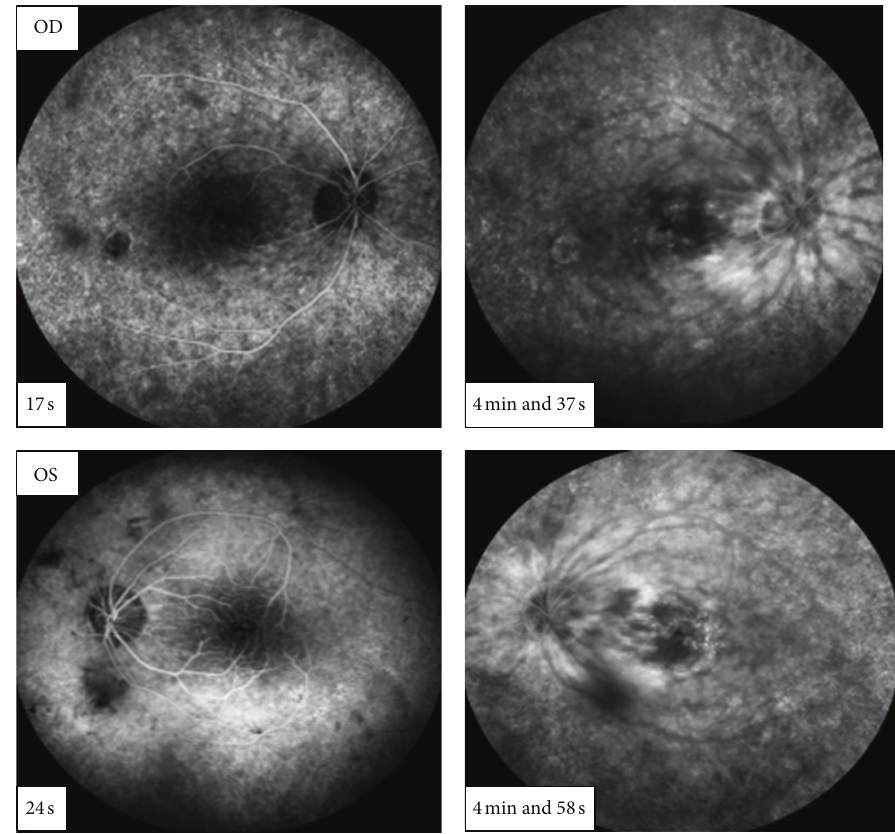
Figure 3: Fluorescein angiography—little accumulation of the dye in the late phases.